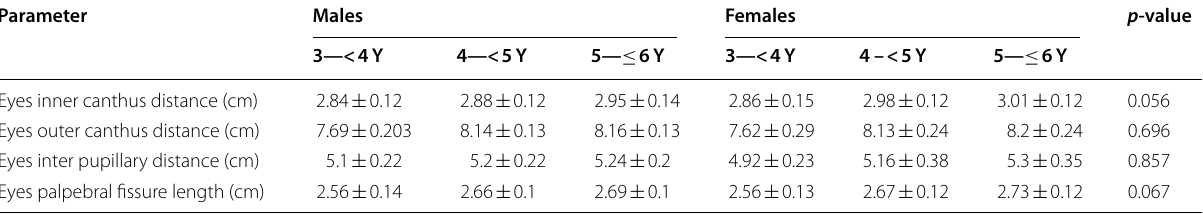
All values are expressed as mean standard deviation (SD) ± All these anthropometric measurements of the eye are within normal average according to Z-score charts for specific age in both sexes